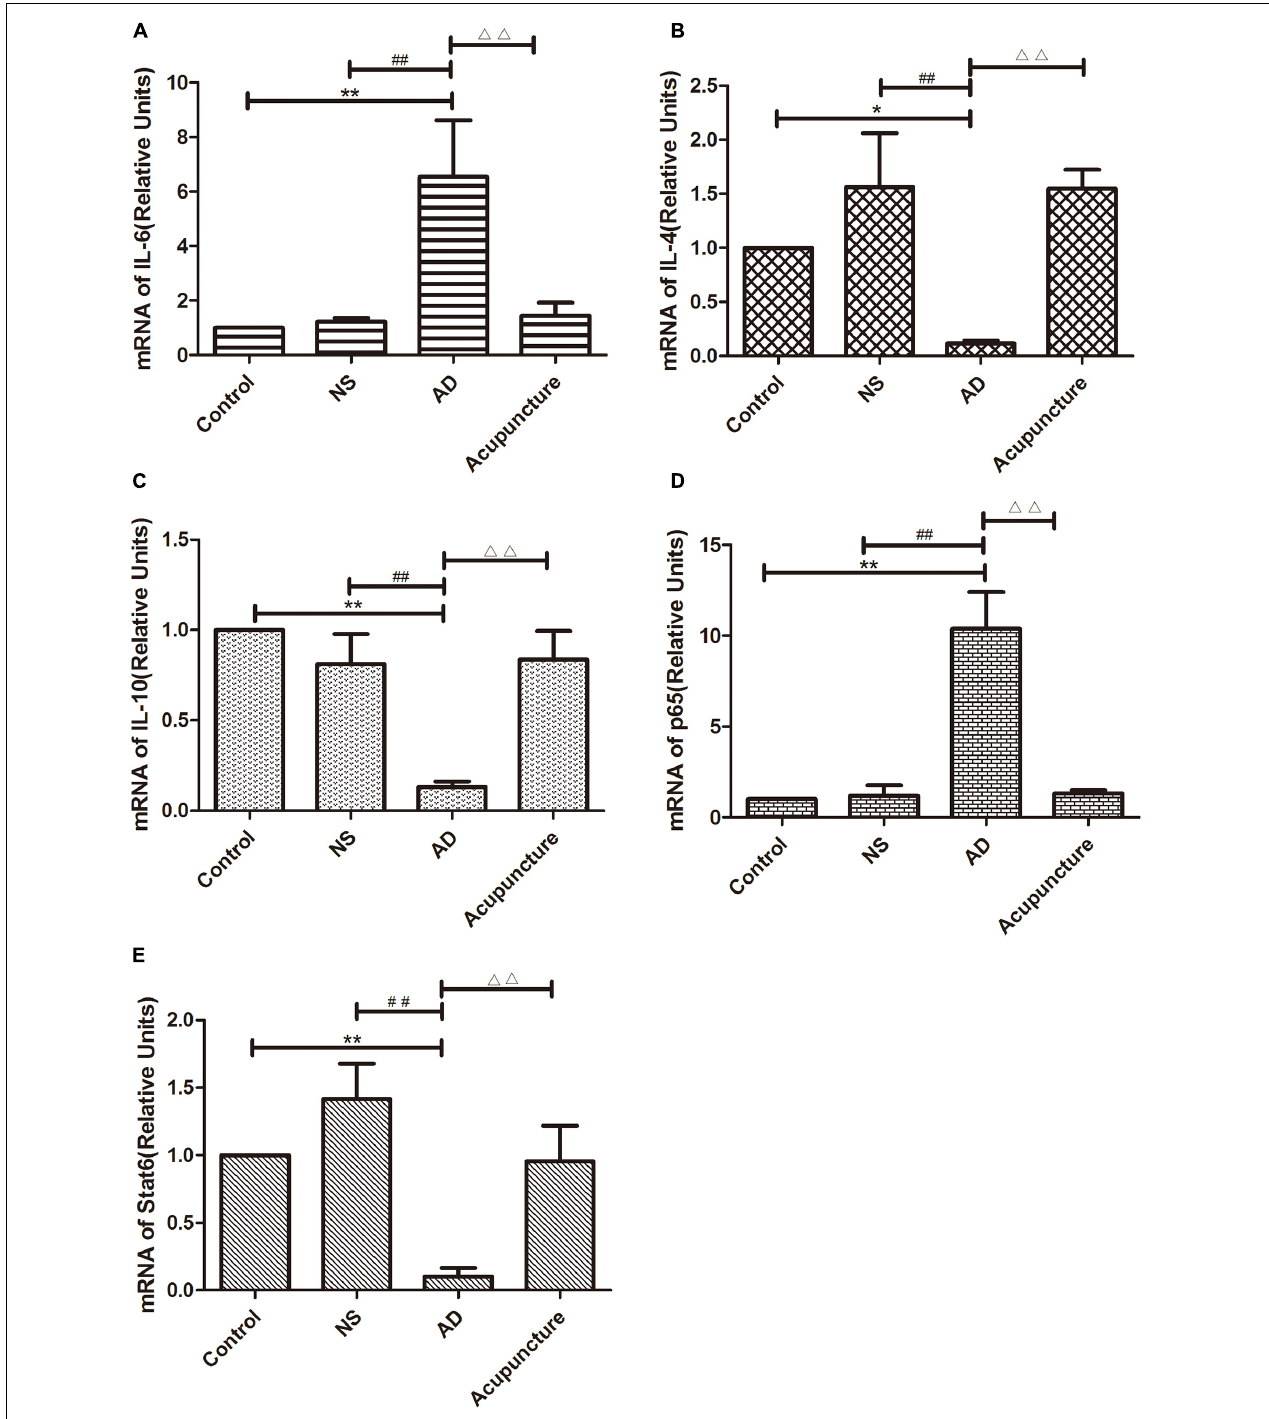
FIGURE 7 | Glia p65 and Stat6 expressed in different groups. (A, B) p65 was stained in glia. (A1–4) Double staining with p65 and Iba1 (CA1 area). (A6–9) p65 and Iba1 (DG area). (B1–4) p65 and GFAP (CA1 area). (B6–9) p65 and GFAP (DG area). p65 and GFAP (CA1 area). (C,D) Stat6 was stained in glia. (C1–4) Stat6 and Iba1 (CA1 area). (C6–9) Stat6 and Iba1 (DG area). (D1–4) Stat6 and GFAP (CA1 area). (D6–9) Stat6 and GFAP (DG area). (Red expresses Iba1 or GFAP-positive cells, green expresses p65- or Stat6-positive cells, and blue expresses DAPI. The white arrow expresses p65 + Iba1 + cells. The pink arrow expresses p65 + GFAP + cells. The yellow arrow expresses Stat6 + Iba1 + cells. The green arrow expresses Stat6 + GFAP + cells.) (A5,B5,C5,D5,E5,A10,B10,C10,D10,E10) The number of positive cells in different groups ( n = 3). Error bars: SE. Compared with Control group, * p < 0.05, ** p < 0.01; compared with NS group, # p < 0.05, ## p < 0.01; compared with AD group, (cid:77) p < 0.05, (cid:77)(cid:77) p < 0.01 ( n = 5).